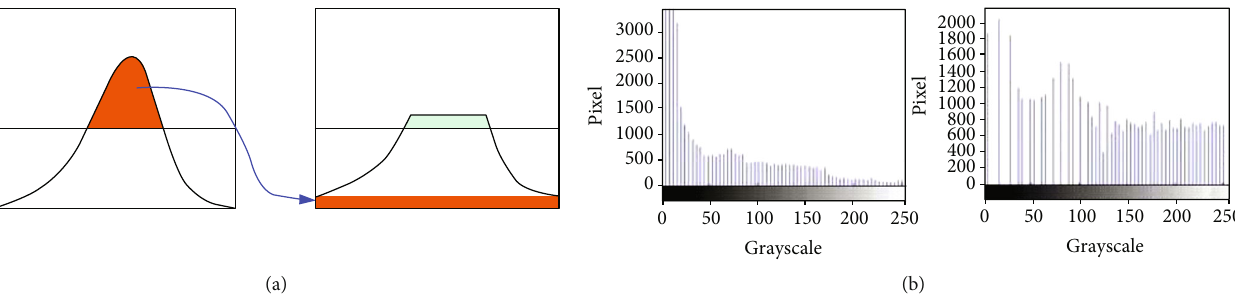
Figure 3: Schematic diagram of the histogram equalization principle. (a) The partial pixels at concentrated grayscale are equally converted to which at diverse grayscale ranging from 0 to 255. (b) The practical processing results based on the principle demonstrated in a supervised intelligent method, the CNN is with high reli- ability and robustness. images. The schematic diagram of the CNN is shown in Figure 4. The CNN consists of the following fi ve parts: the input layer, convolution layer, pooling layer, fully con- nected layer, and the output layer. The key advantage of this method is that it could extract local data features through convolution and pooling operations. Besides, as